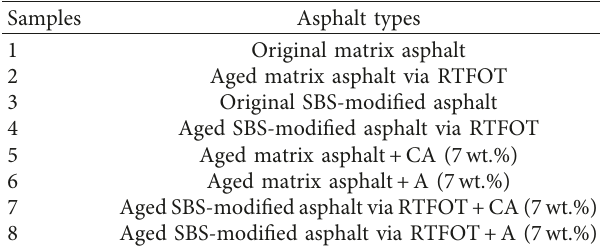
Table 3: Matrix asphalt and SBS-modified asphalt samples.